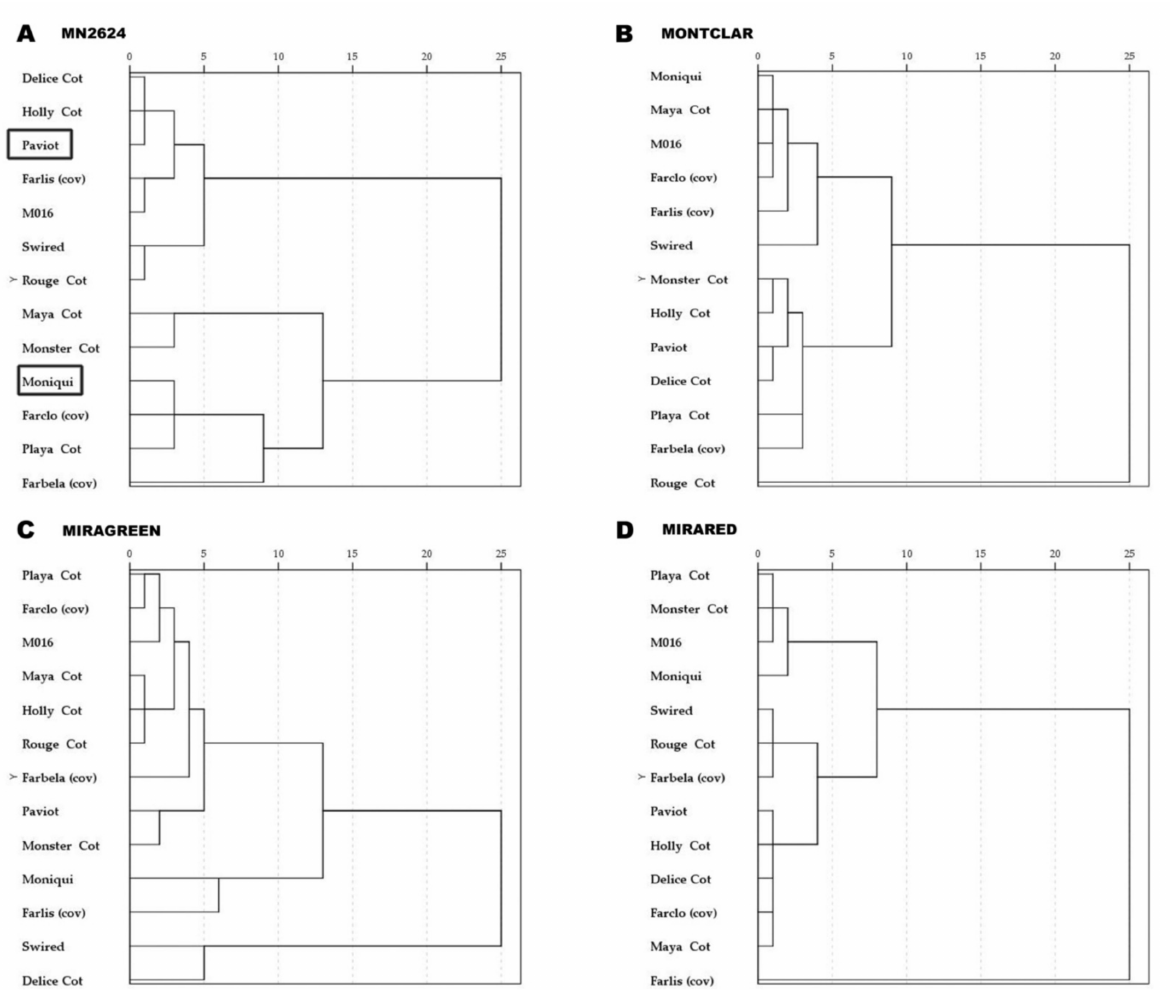
Figure 3. Dendrograms showing the distribution of the 13 apricot cultivars grafted on four different rootstocks: ( A ) ‘MN2624’, ( B ) ‘Montclar’, ( C ) ‘Miragreen’, and ( D ) ‘Mirared’ at 42 days after grafting. Dendrograms are based on the different histological characters evaluated: necrosis line, cell proliferation, cell arrangement, and cellular shape. The apricot cultivars ‘Paviot’ and ‘Moniqui’ were grafted on ‘MN2624’ and used as controls considered compatible and incompatible, respectively